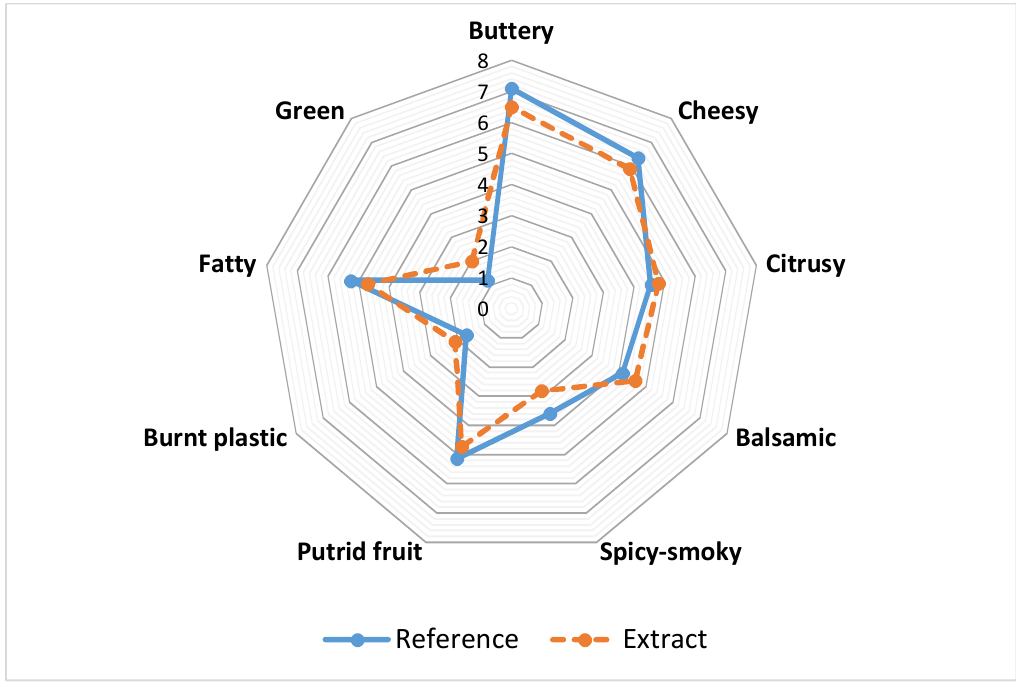
Figure 1. Odor sensory features of black cumin seed extract and its aromatic extract.